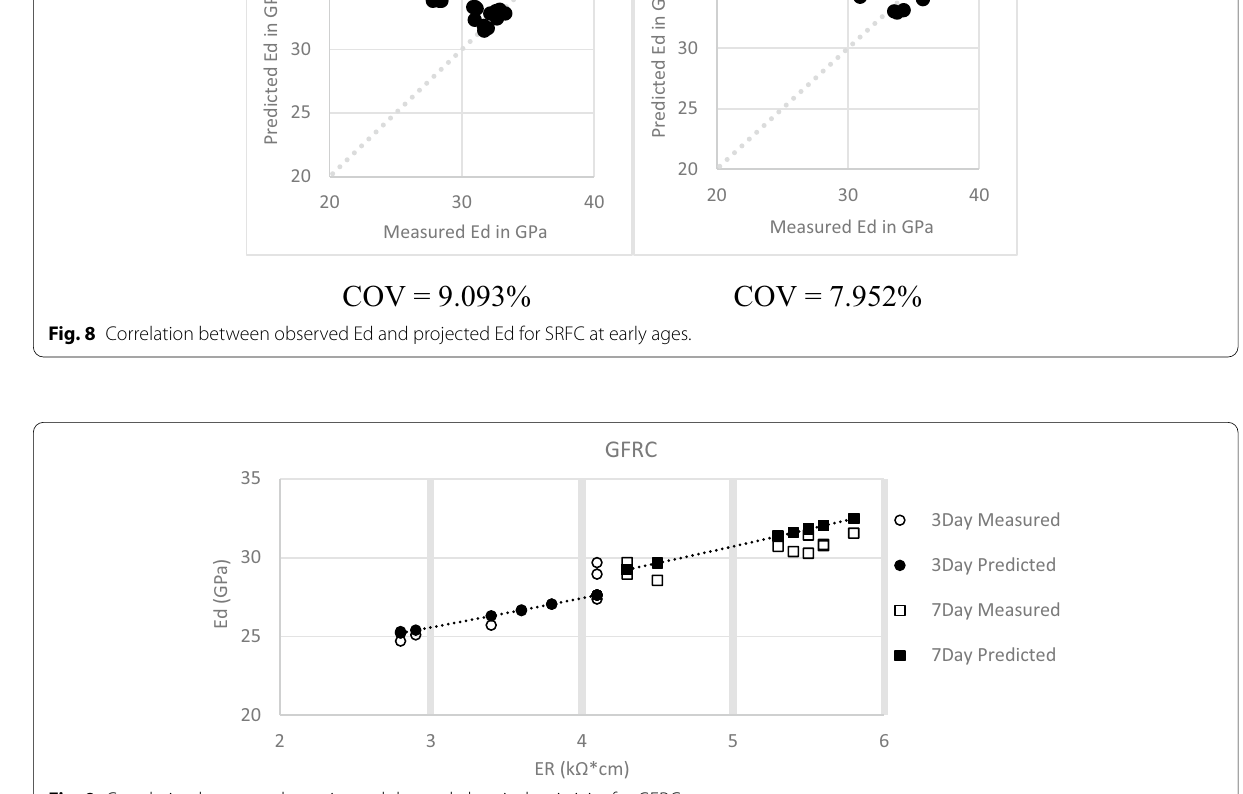
Fig. 9 Correlation between dynamic modulus and electrical resistivity for